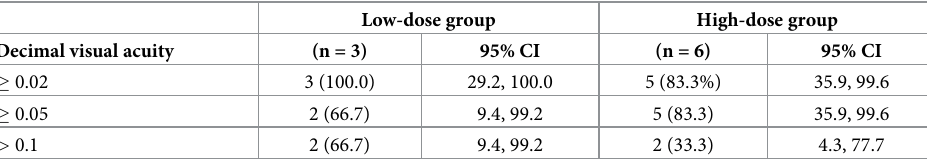
Table 7. Visual acuity at week